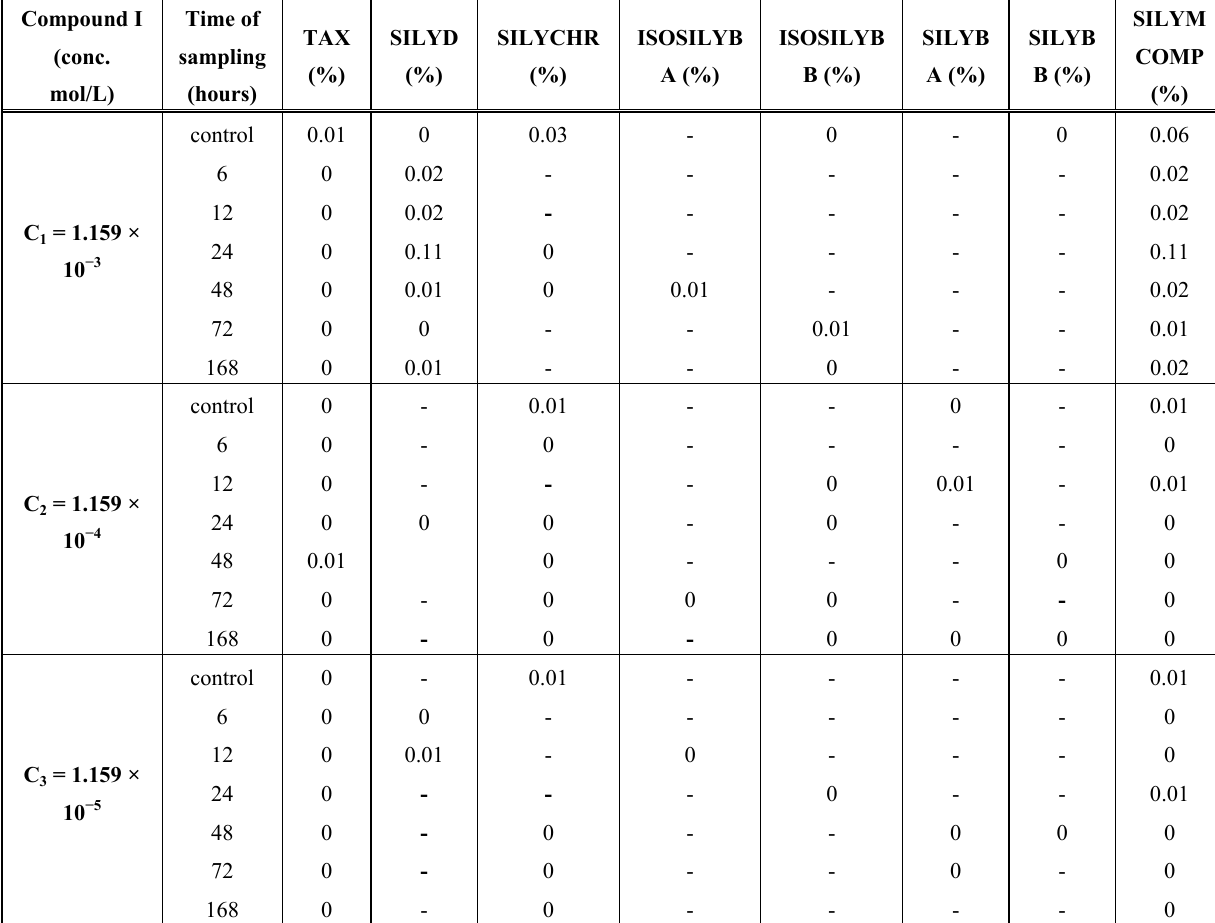
Table 2. Content of silymarin complex substances (%) and taxifolin (%) in Silybum marianum suspensions culture after elicitor